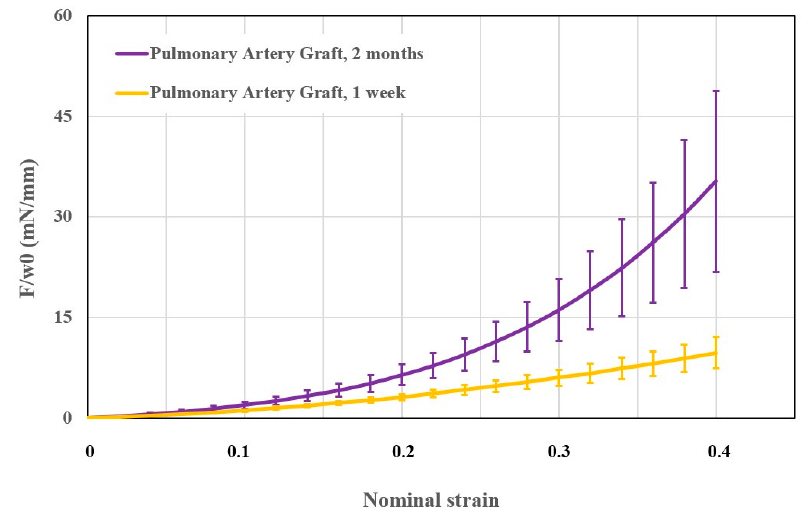
Figure 3. Graph showing the comparison of PAG mechanical properties at 1 week (yellow, n = 5) and 2 months (purple, n = 10). The x-axis shows the nominal strain and the y-axis the membrane force. Data presented as mean ± standard error of mean. F: tensile force; w0: initial width.